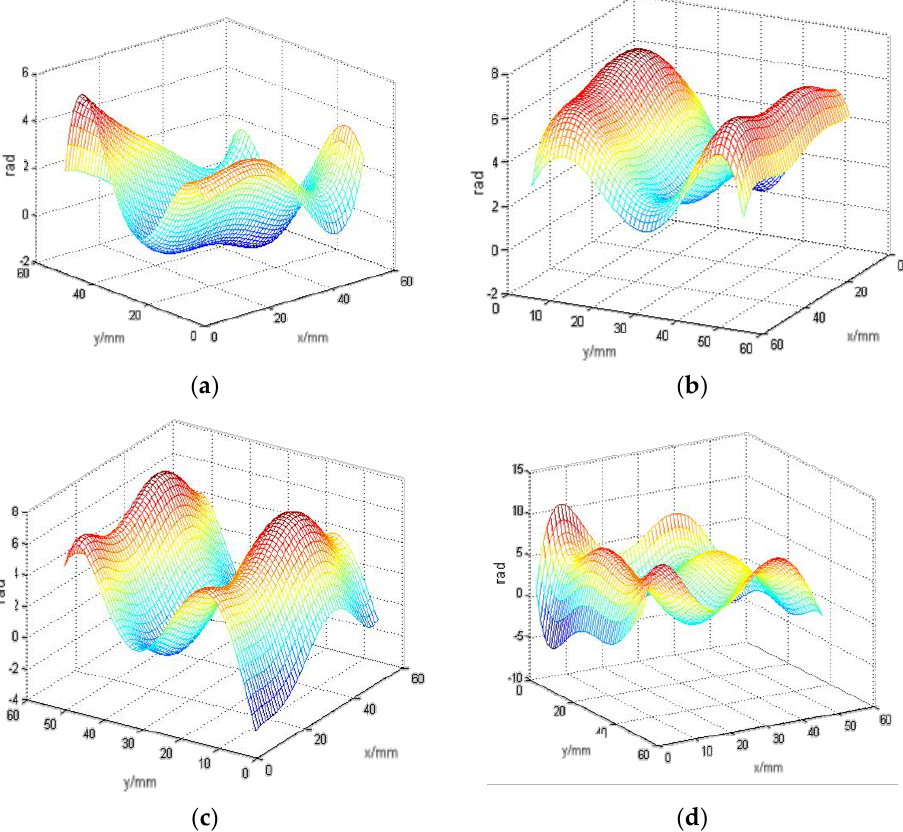
Figure 9. The results of wavefront reconstruction at different distances: ( a ) 1 m; ( b ) 2 m; ( c ) 3 m; and ( d ) 4 m.